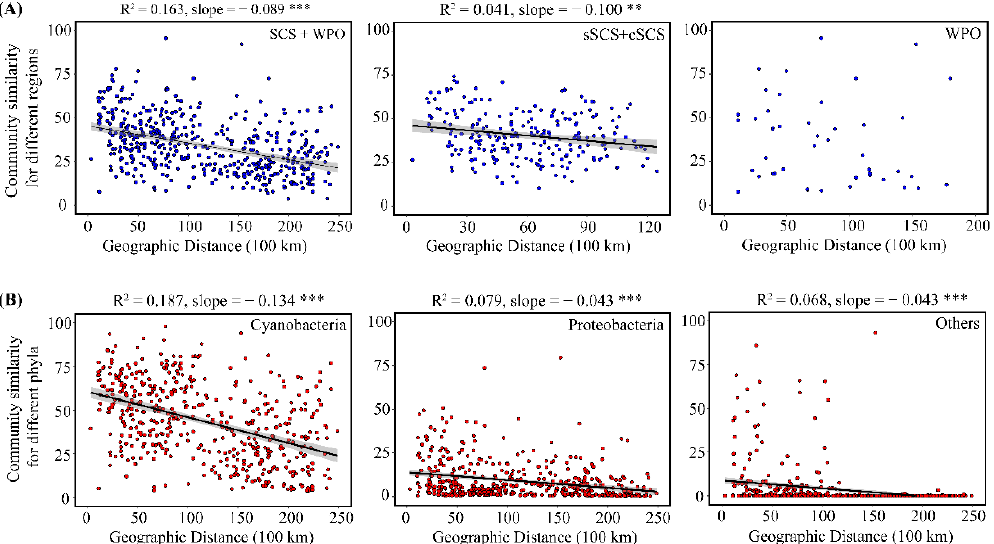
Figure 5. Community similarity for different regions ( A ) and Community similarity for different 810 phyla ( B ). (** p < 0.01; *** p < 0.001).